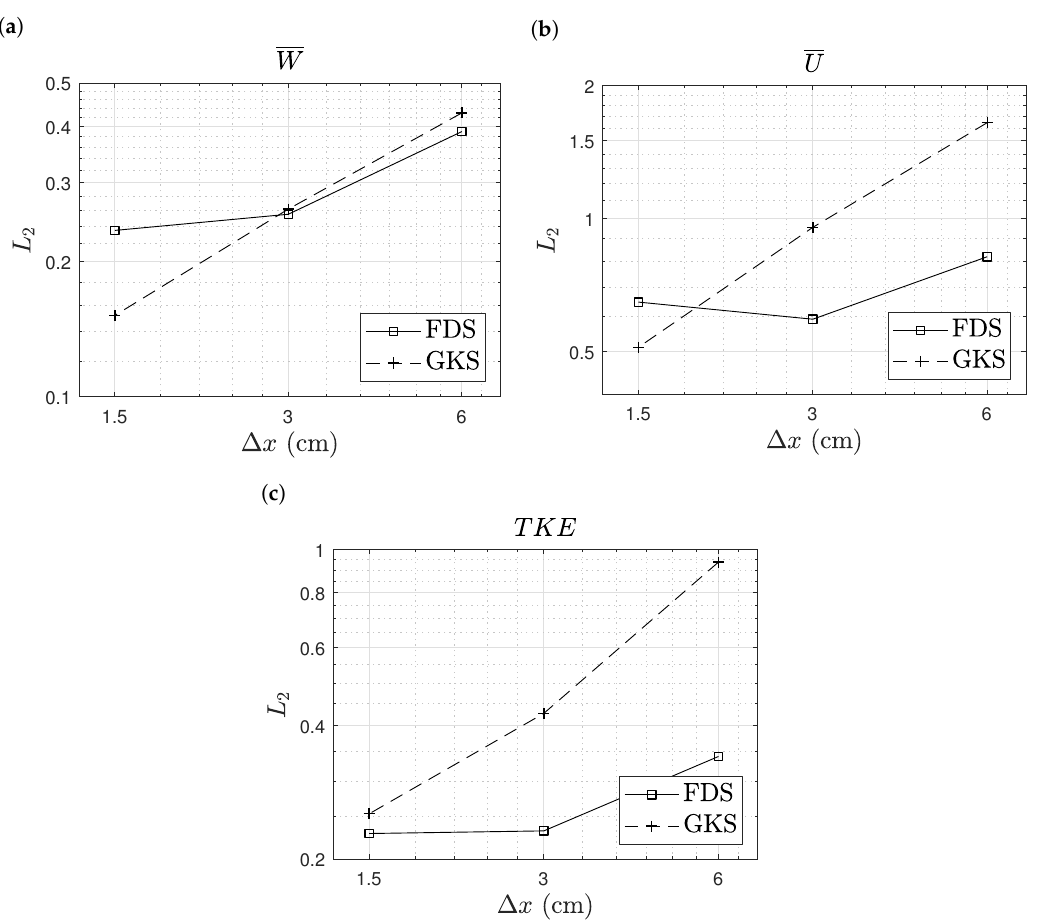
Figure 14. Sandia flame, Test 24: L 2 deviation of the simulation results from the experimental data. Axial velocity ( a ), radial velocity ( b ) and turbulent kinetic energy ( c ).